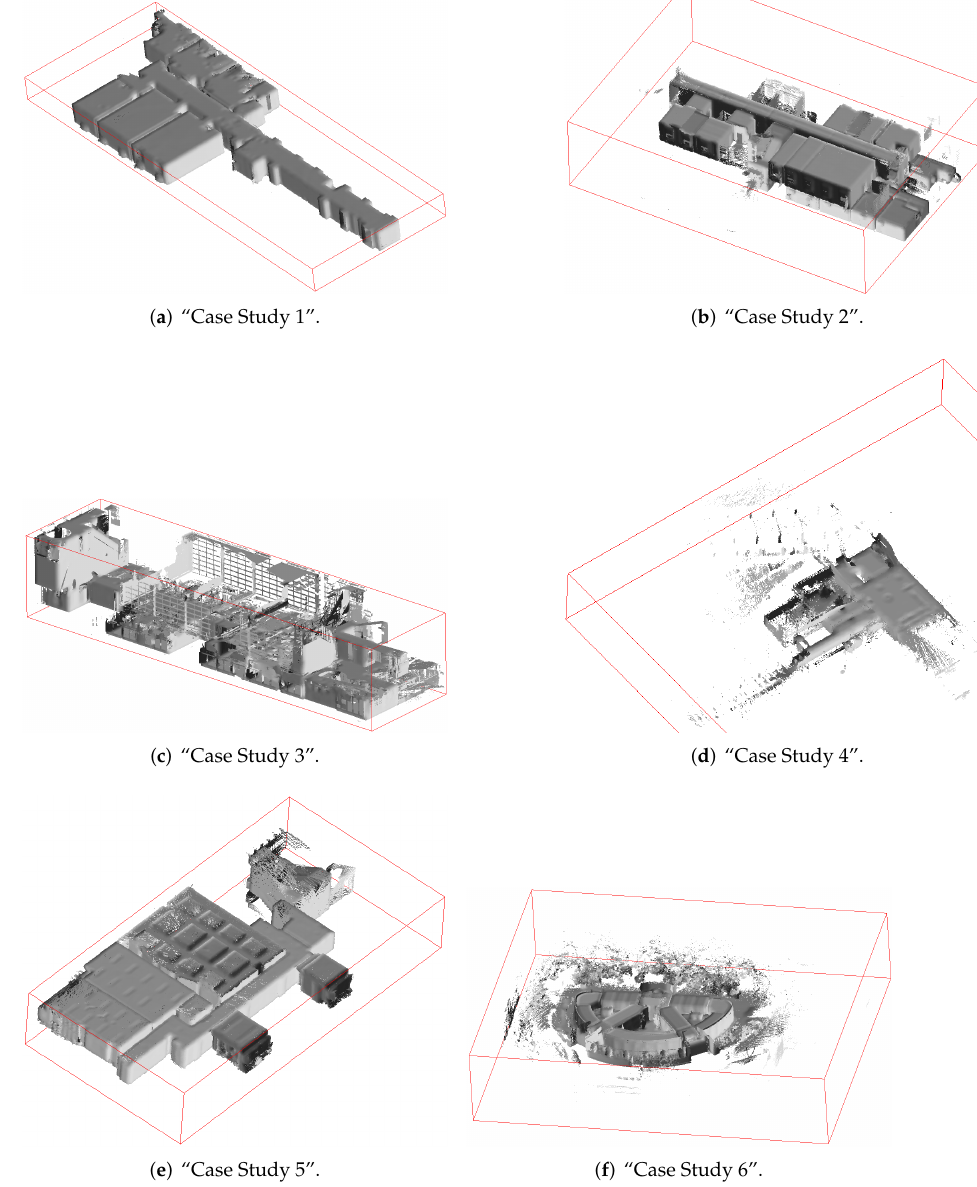
Figure 13. The point clouds of the ISPRS Indoor Modeling Benchmark dataset [95,96] used for evaluation. The red box indicates the aligned ground truth